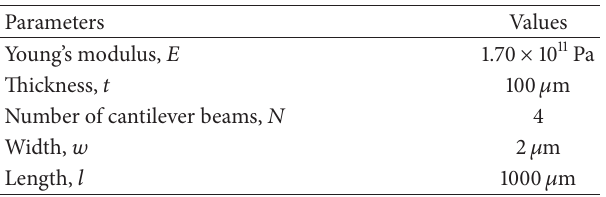
Table 2: Parameters of spring